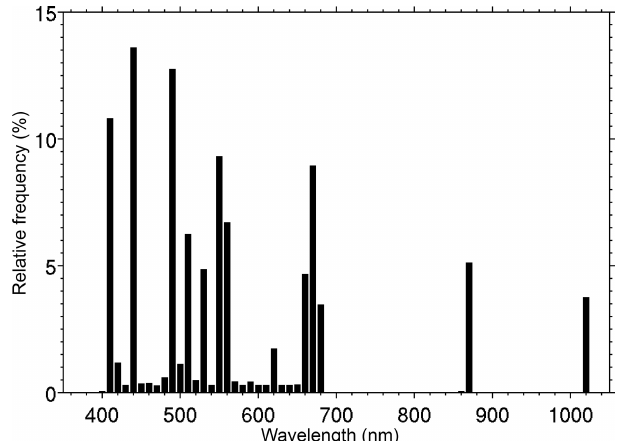
Figure 1. Relative spectral frequency of remote-sensing reflectance in the final table, using 10nm wide class intervals, defined as the ratio of the number of observations at a particular waveband to the total number of observations at all wavebands, multiplied by 100 to report results in percentage. Data at a total of 611 unique wave- lengths, between 404.7 and 1022.1nm, were